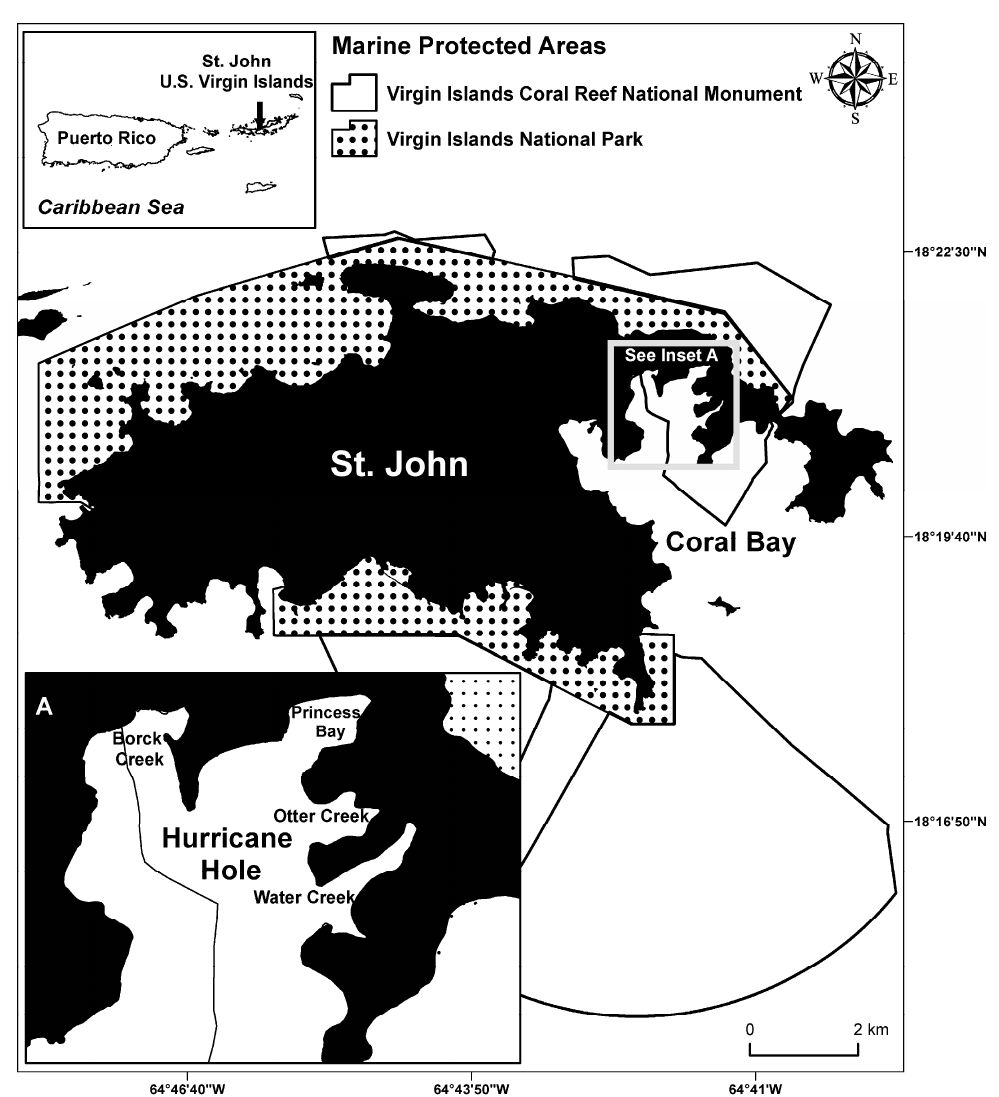
Figure 1. Location of St. John, US Virgin Islands, and the mangrove-lined bays in Hurricane Hole, within Virgin Islands Coral Reef National Monument.